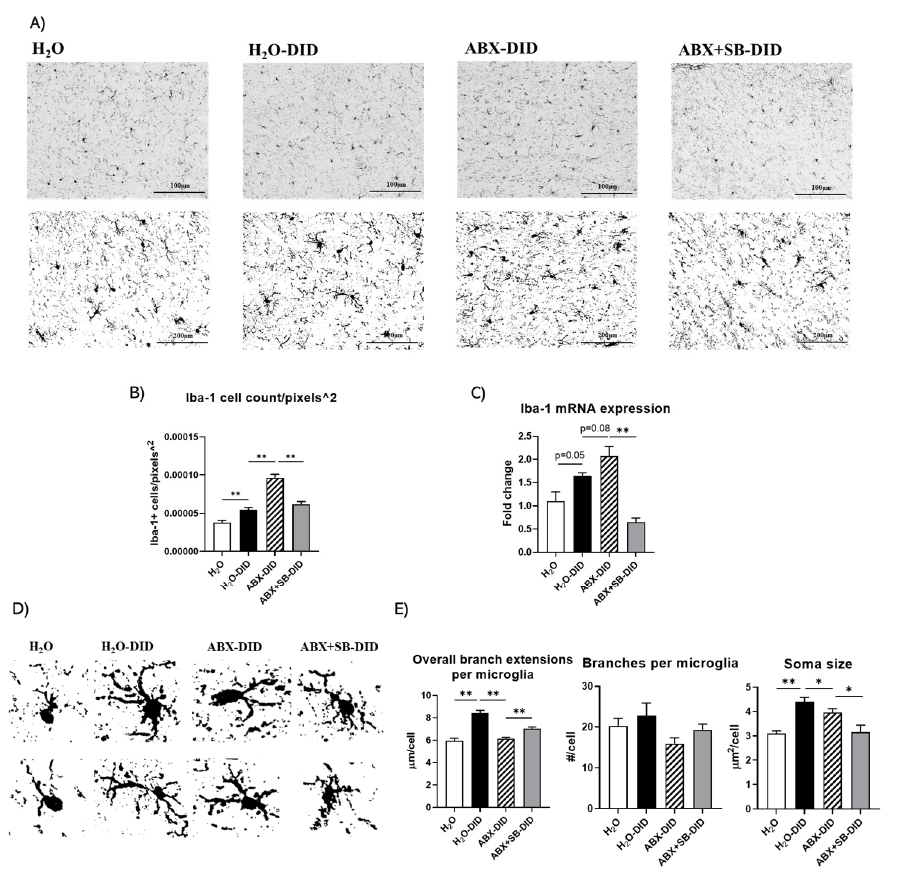
Figure 3. The effects of ABX treatment and/or SB supplementation on DID-induced changes on microglia. ( A ) IHC images of hippocampal microglia. Upper row—20× DAB images (scale bar = 100 μ m); lower row—40× threshold images (scale bar = 20 μ m). ( B ) Analysis of Iba-1-positive cell number; ( C ) mRNA levels of Iba-1; ( D ) Higher magnification capture of individual microglia to explore their representative morphology; ( E ) Analysis of microglia extension length, extension number and cell body (soma) size. Data are presented as Mean ± SEM, n = 8/group; Ordinary one-way ANOVA with Tukey multiple comparisons, * p < 0.05, ** p < 0.01.